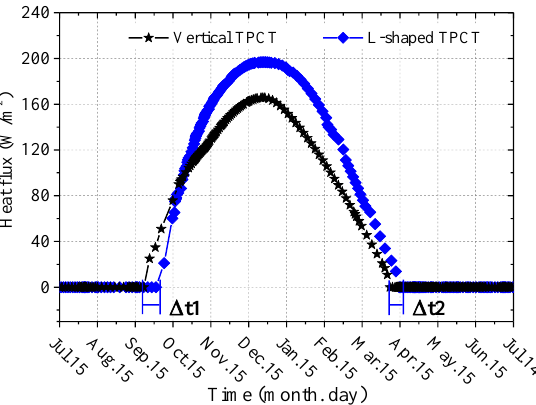
Figure 12. Comparison curves of the heat flux of the vertical TPCT and L-shaped TPCT of the composite subgrade.